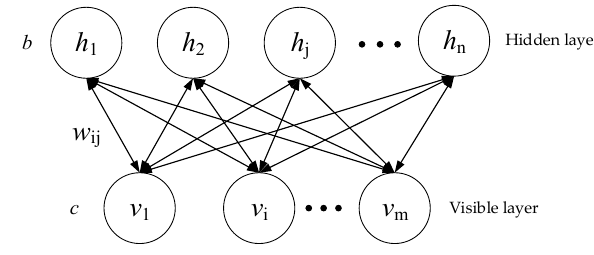
Figure 2. Restricted Boltzmann machine.